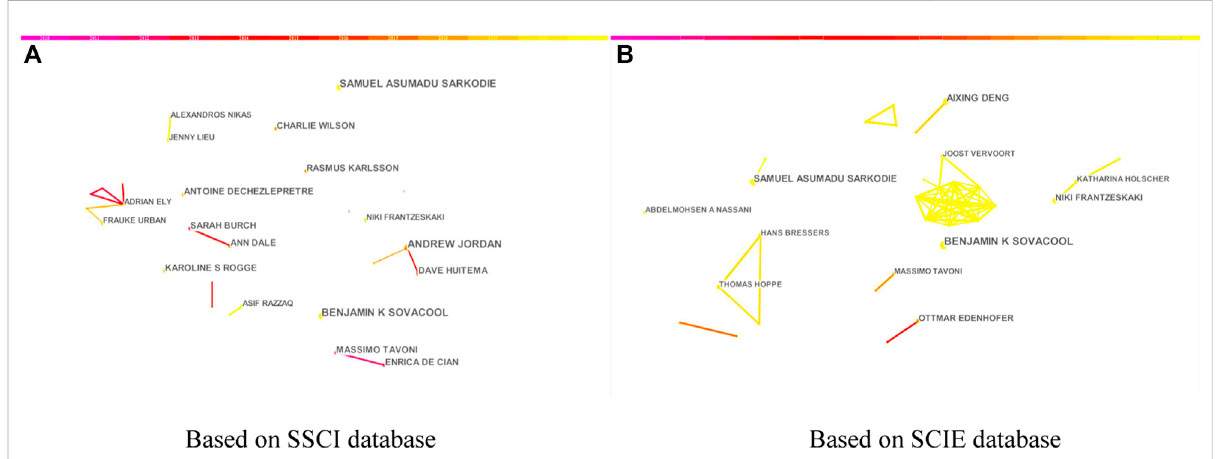
FIGURE 1 Map of the author co-authorship network of climate innovation research. (A) refers to the SSCI database and (B) refers to the SCI database.